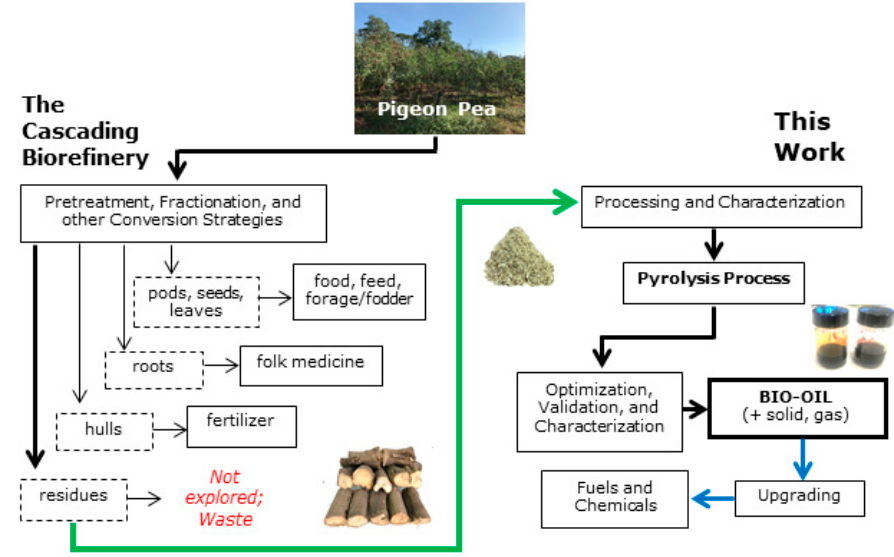
Figure 1. Integrating pyrolysis technology in a cascading biorefinery approach for pigeon pea [27,28].